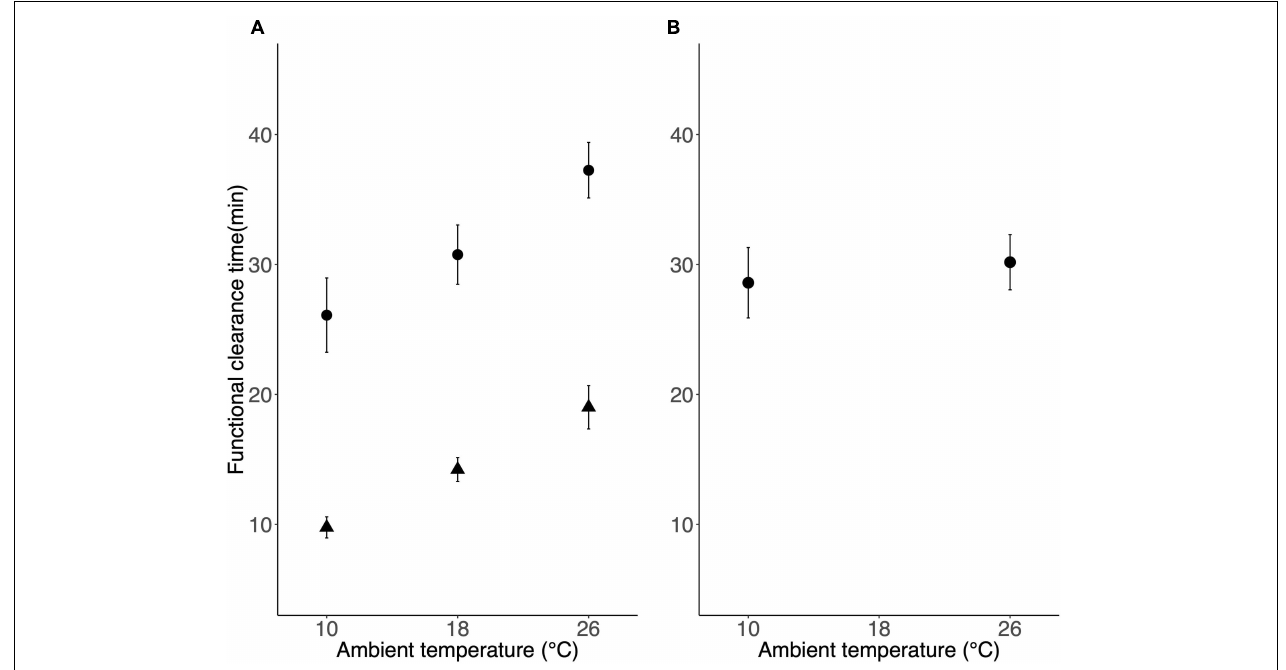
FIGURE 2 | Functional clearance times (mean ± SE) of animals injected with 5 mg.kg − 1 Alfaxalone for (A) ringtail possums (triangles, n = 11) and brushtail possums (circles, n = 9), following 7–8 days of exposure to different ambient temperatures and (B) for brushtail possums ( n = 10) following short-term ( < 24 h) exposure to different ambient